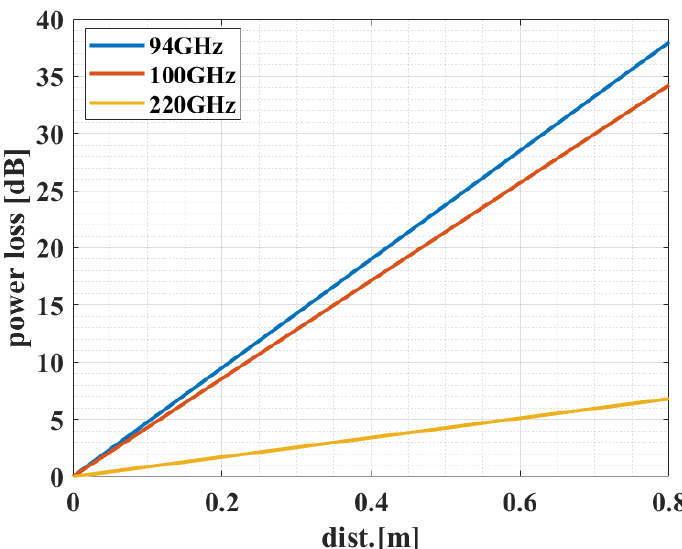
Figure 7. Power loss vs. distance for different frequencies of n e = 1.6 × 10 18 m − 3 and f e = 4.2 × 10 10